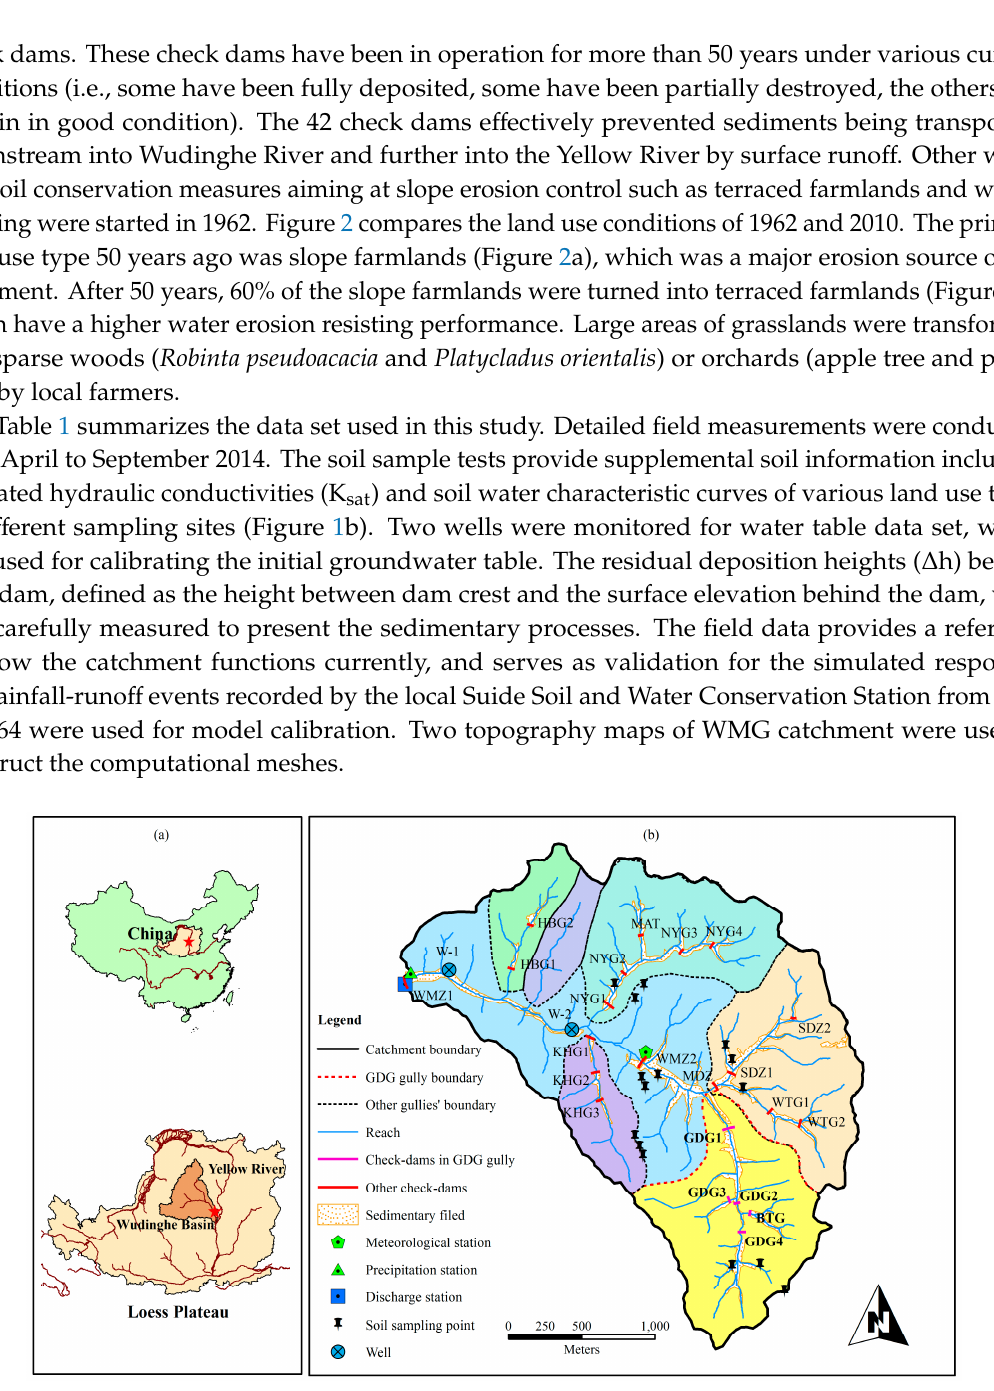
Figure 1. ( a ) Location of WMG catchment (the red star); ( b ) check dam distributions and measurement locations of soil characteristics and hydrologic data. Polygons with different colors represent different gullies and the red dash line depicts the boundary of GDG catchment.